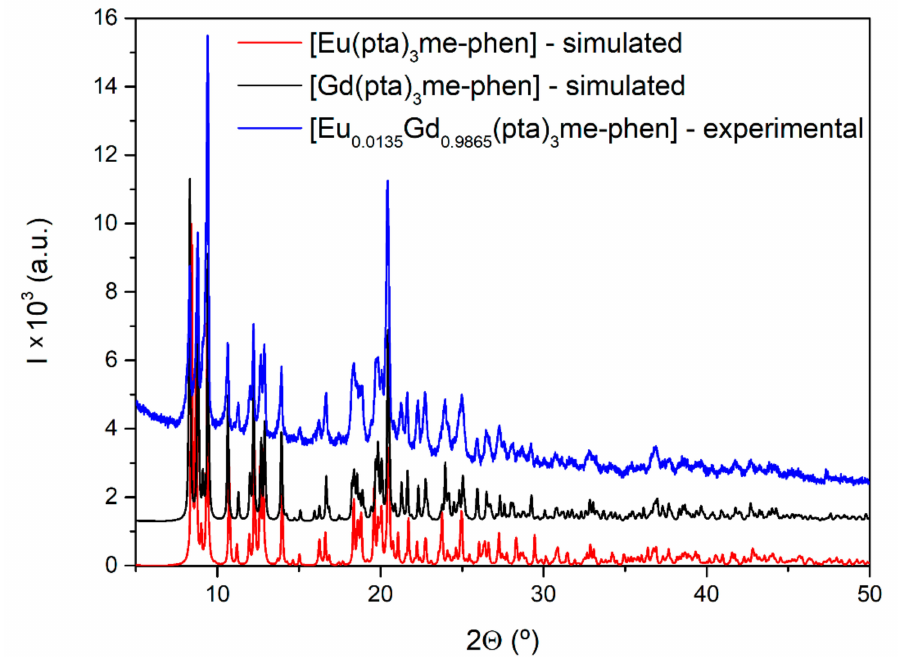
Figure 1. Simulated and experimental powder diffractograms.